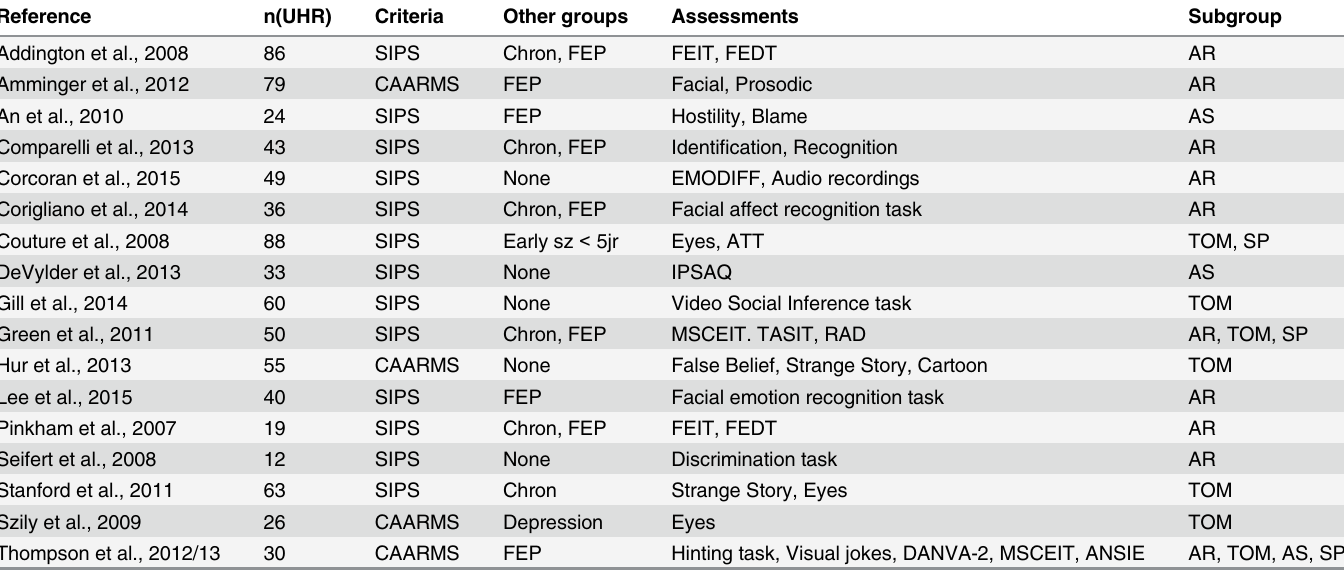
Table 1. Overview of included studies.